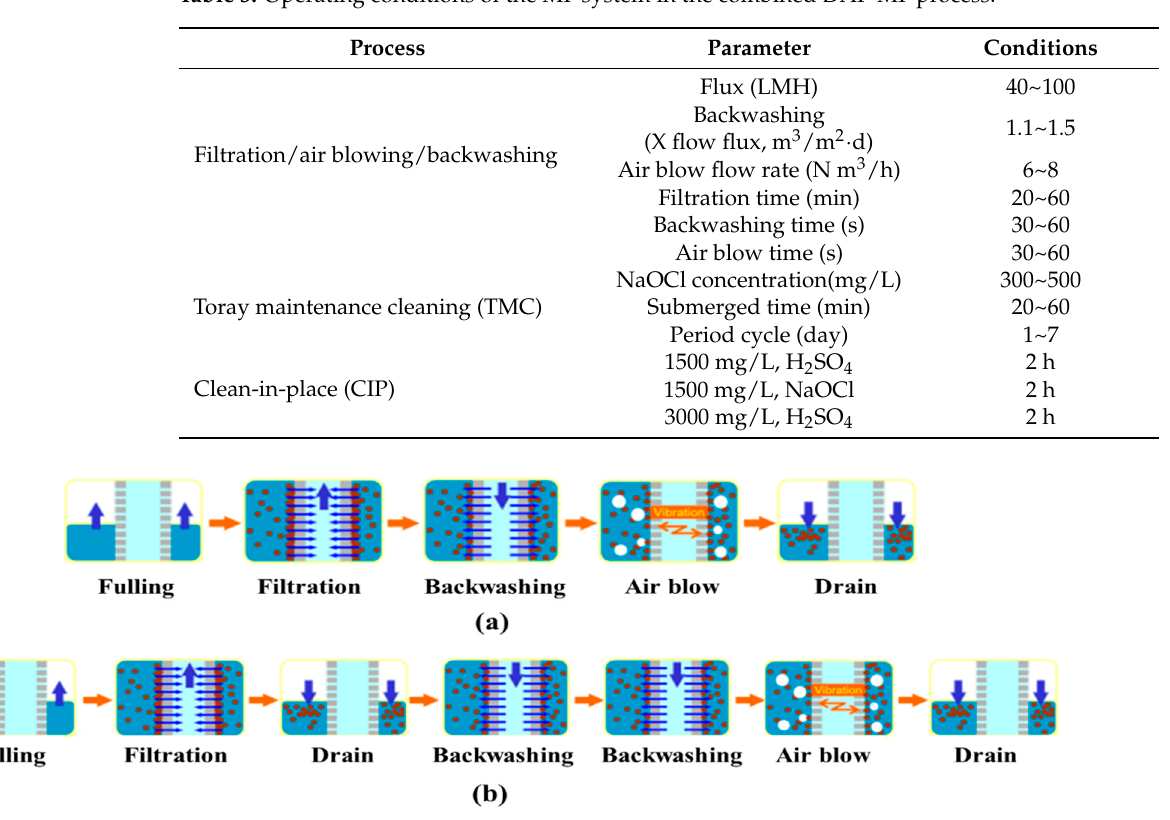
Figure 1. Schematic diagram of the combined DAF-MF process. Table 3. Operating conditions of the MF system in the combined DAF-MF process.